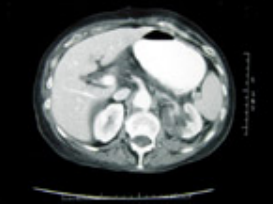
FIGURE 1. Contrast CT scan showing the partial uptake of the left kidney.